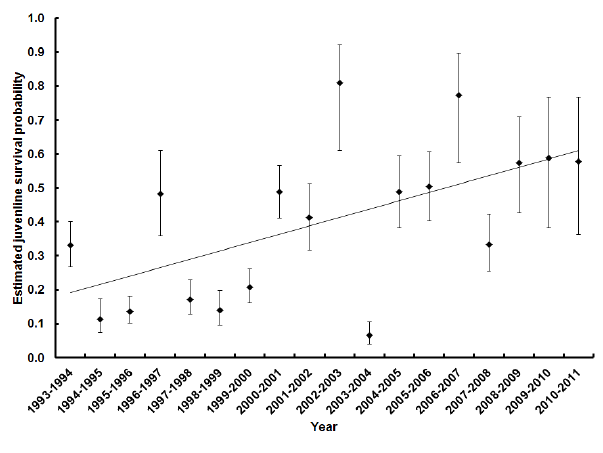
Fig. 7 . Trend estimated from survival analyses for first-year survival of juvenile Canada Geese banded on Akimiski Island, Nunavut, 1993-2010. The trend variable was found to explain significant variation in juvenile first-year survival (see text). Bars are 95% confidence